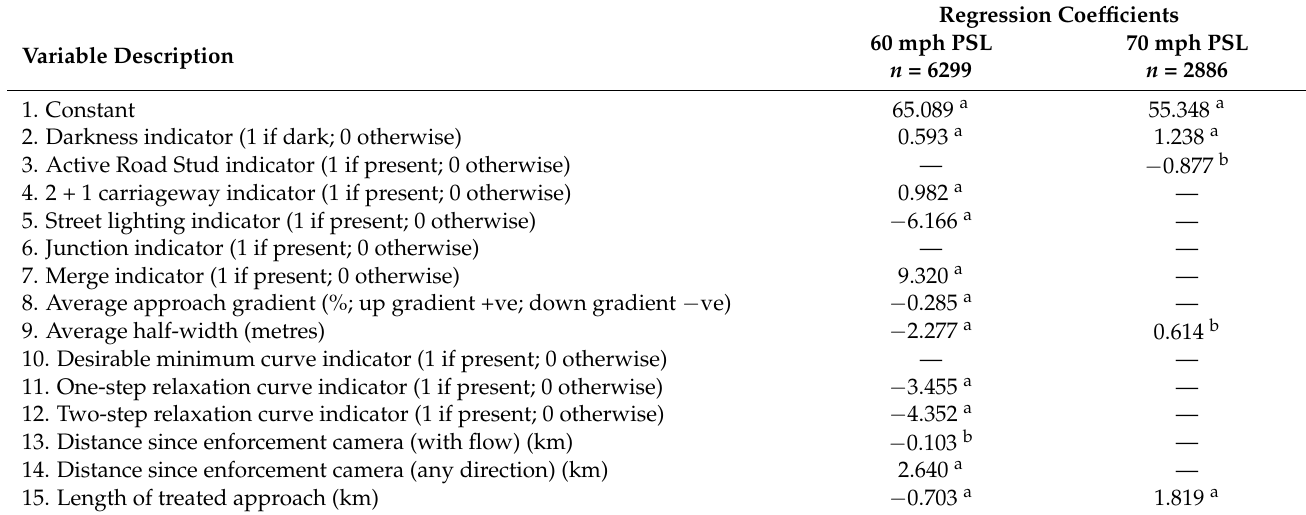
Table 9. Linear Regression